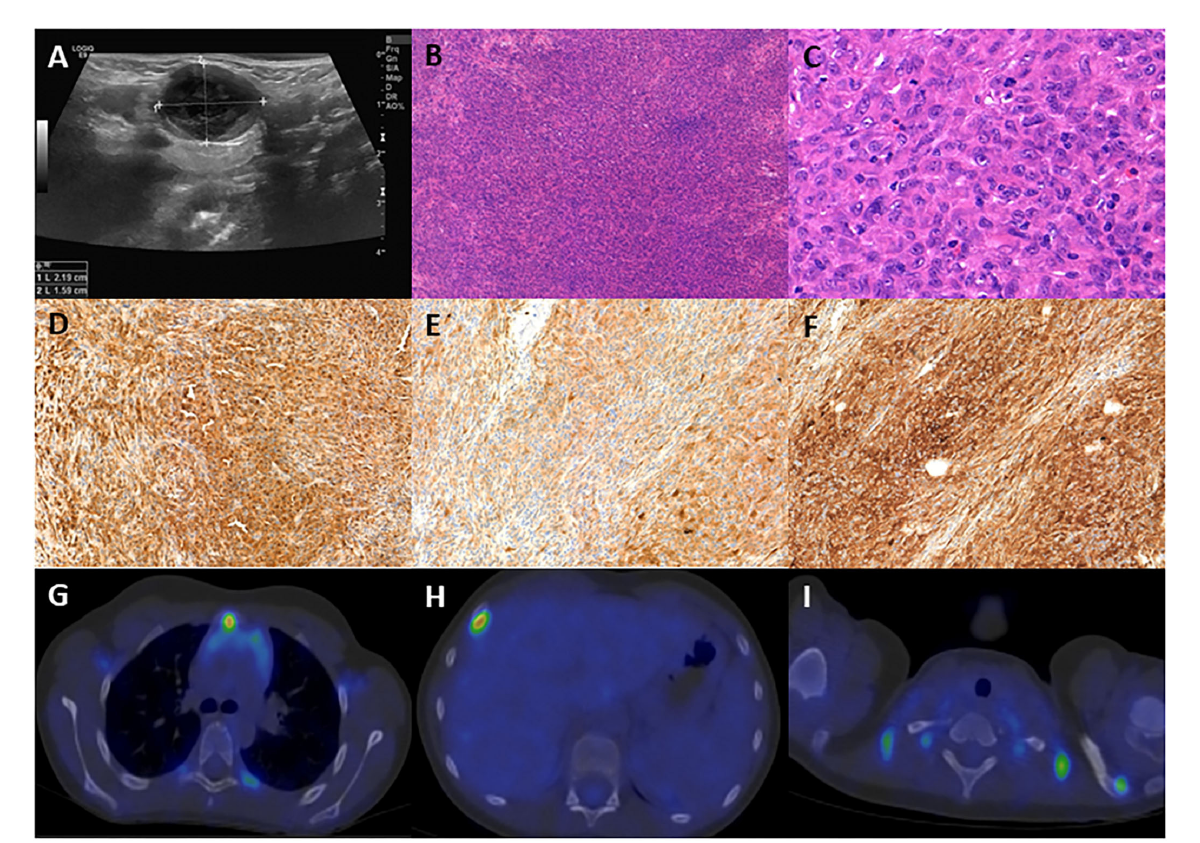
FIGURE1 (A) Ultrasound picture of the pathologic submandibular lymph node, size: 2.19 × 1.59cm. (B) The excisional biopsy demonstrates diffuse architecture of the lymph node with atypical cell infiltration (100 × , H&E). (C) The lesion is composed of large, elongated or epithelioid cells with vesicular nuclei, multiplex nucleoli, and eosinophilic cytoplasm (400 × , H&E). (D) The neoplastic cells are positive for CD68 (100 × ). (E) The neoplastic cells are positive for S100 (100 × ). (F) The neoplastic cells are positive for fascin (100 × ). (G) PET-CT demonstrates infiltration of the sternal manubrium. (H) PET-CT demonstrates infiltration of the 4th right rib. (I) PET-CT demonstrates infiltration of the acromial end of the left clavicle.